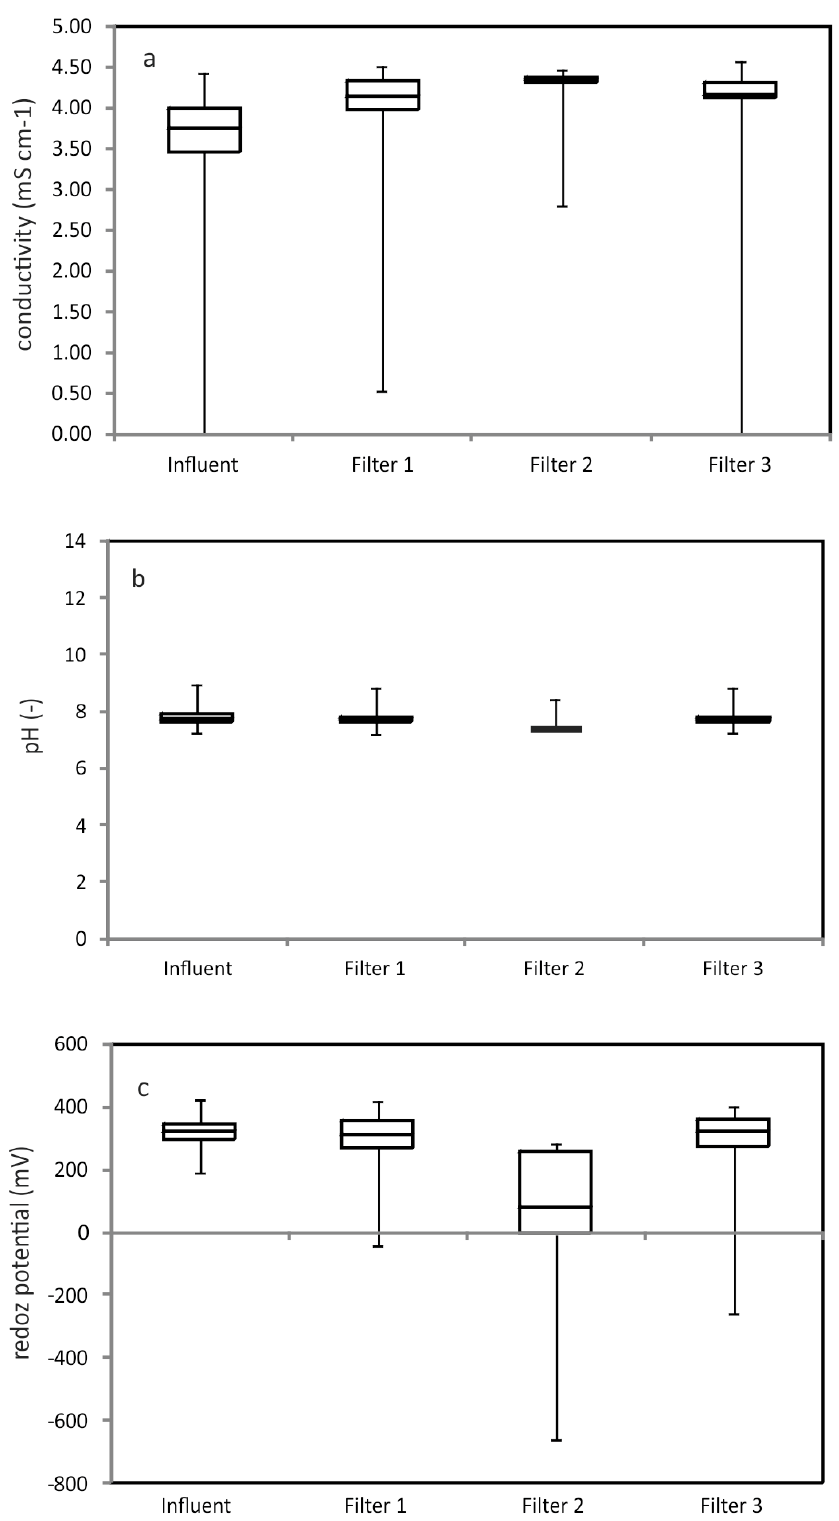
Figure 3. Boxplots representing the following physical–chemical parameters: ( a ) electrical conductivity, ( b ) pH, ( c ) redox potential, monitored inline in the influent and effluents of all three filters throughout the duration of the experiment.